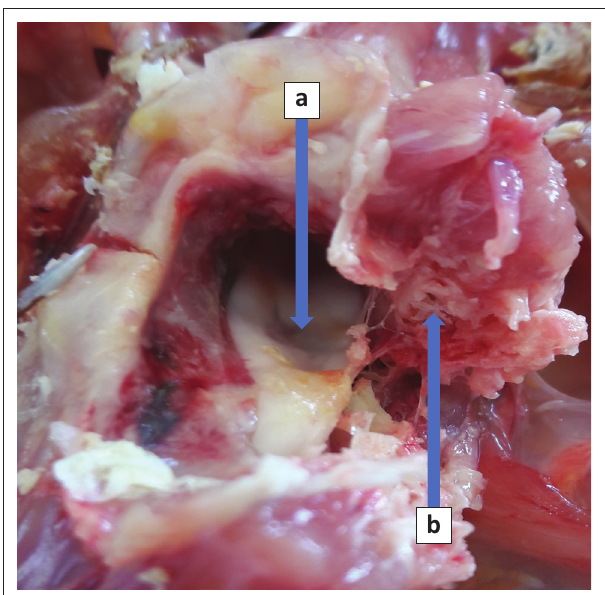
FIGURE 3: Close-up of the cervical spinal cord compression (a) caused by the feather cyst as seen through the foramen caused by bone lysis and the sectioned cervical vertebra (b).